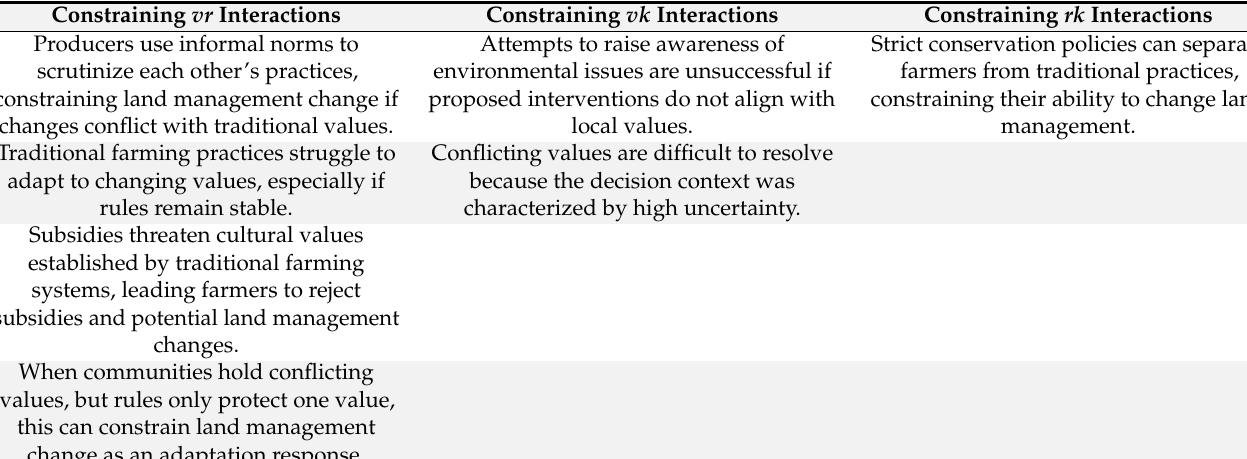
Table 6. The values–rules, values–knowledge, and rules–knowledge interactions that constrained land management change as an adaptation